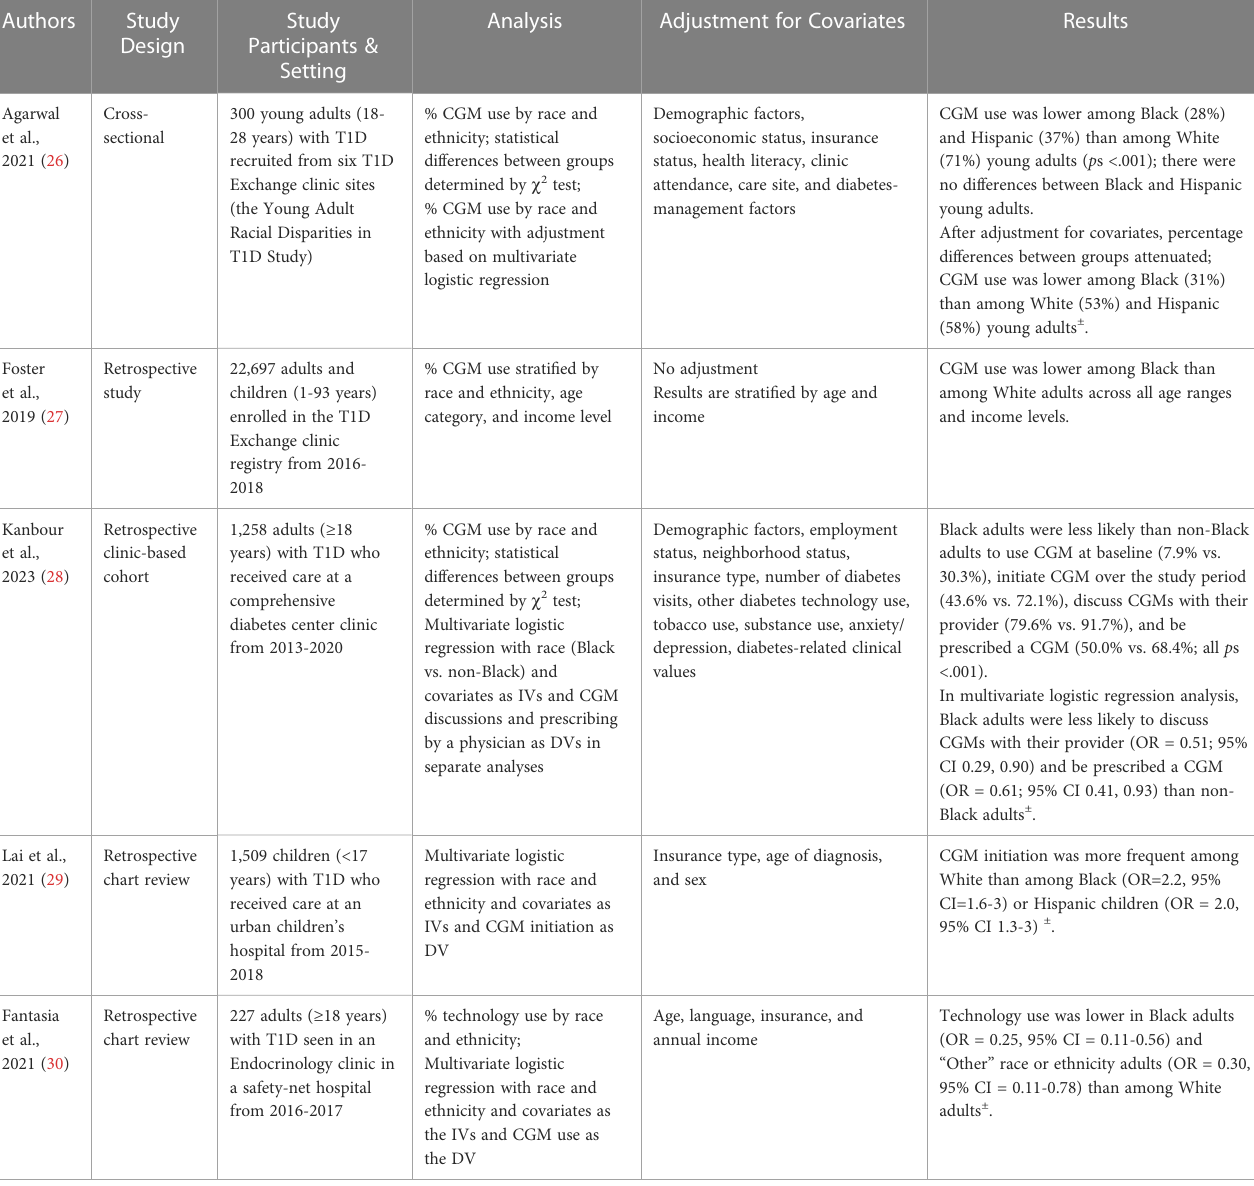
TABLE 1 Characteristics of studies examining CGM use by race and